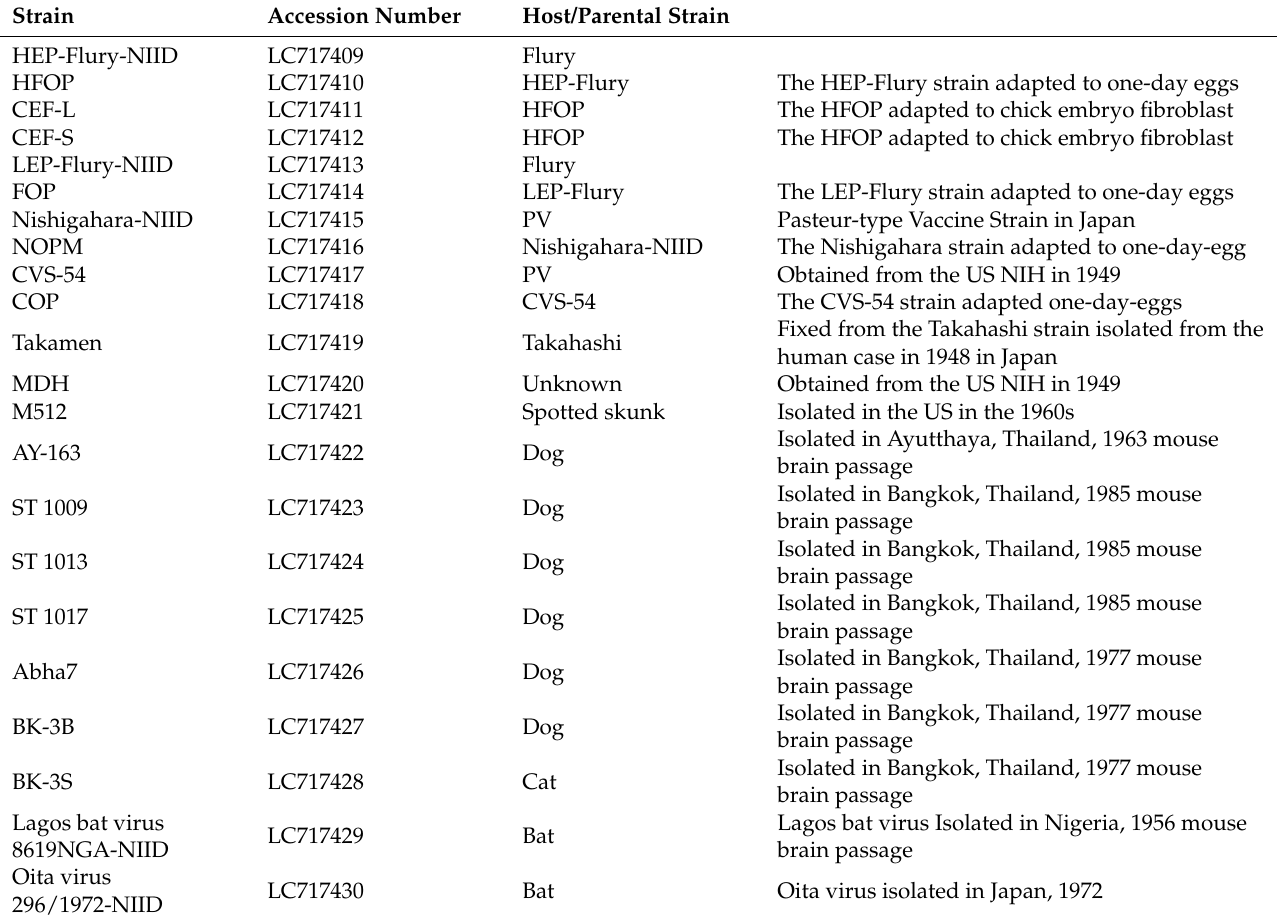
Table 1. List of virus strains analyzed in this